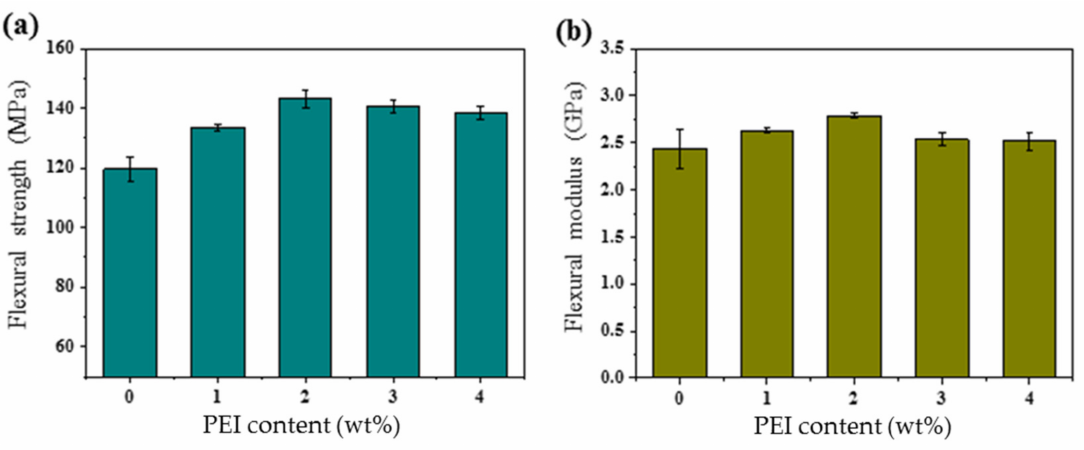
Figure 5. Flexural strengths of the DGEBA/PEI blends: ( a ) flexural strength and ( b ) flexural modulus.